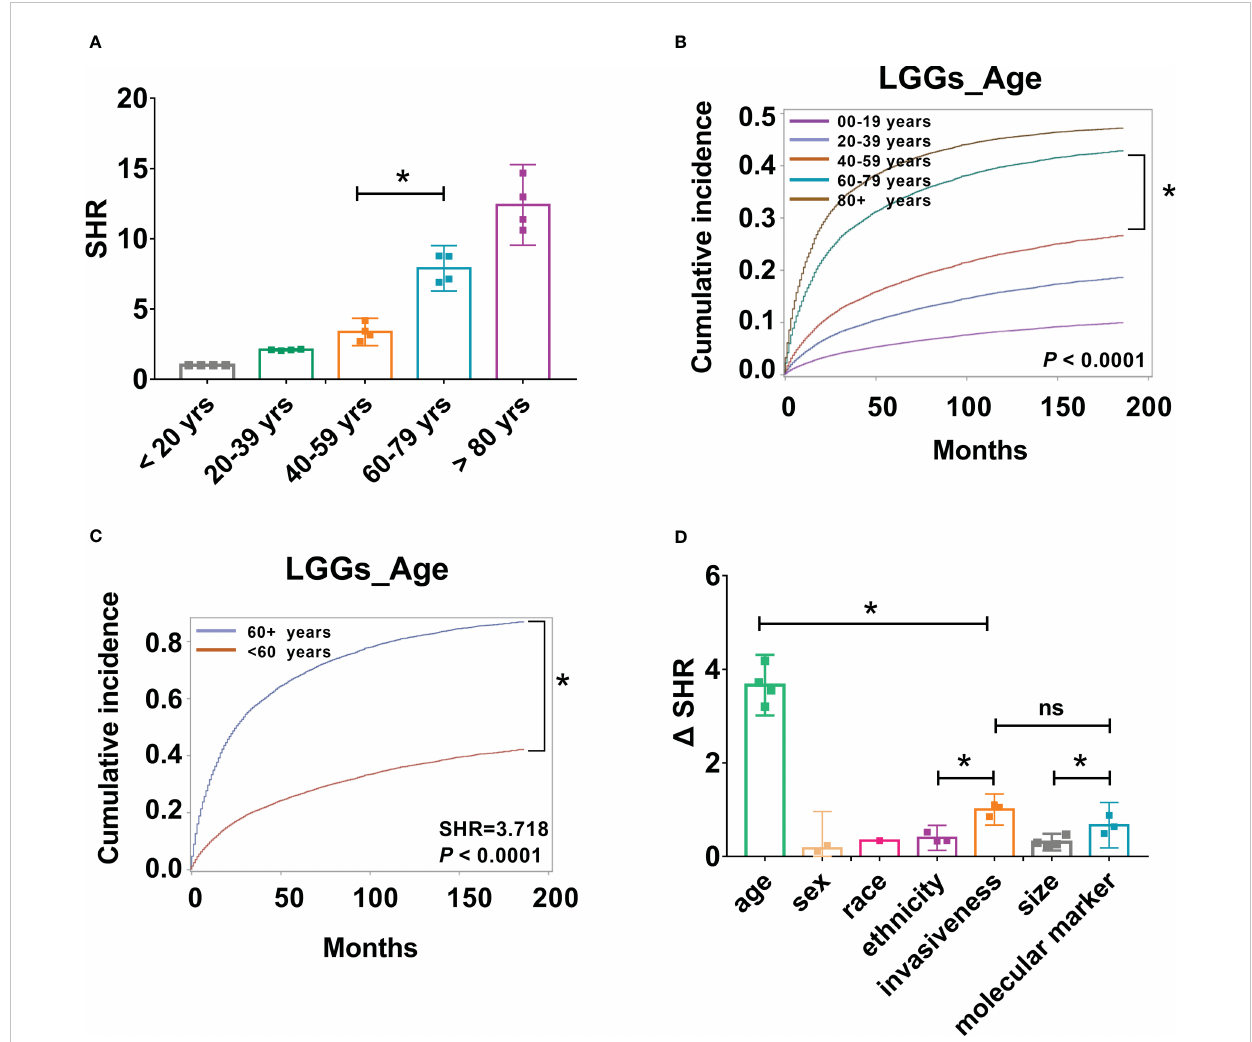
FIGURE 5 Patient age, tumor aggressiveness, and molecular markers may be important factors in risk strati fi cation of LGG patients. (A) . SHR from four groups, including all LGGs, astrocytoma, oligodendrogliomas, and mixed gliomas across different age groups were compared, * P < 0.001. (B) . Cumulative incidence curves of LGGs by fi ve age groups, 0-19, 20-39, 40-59, 60-79, and 80+ years, * P < 0.001. (C) . Cumulative incidence curves of LGGs by two age groups, < 60, and 60 + years, * P < 0.001. (D) . Absolute differences in SHR ( D SHR) between each reference and subtype were calculated and compared across different factors, including age, sex, race, ethnicity, invasiveness, size, and molecular markers. ns, no signi fi cant